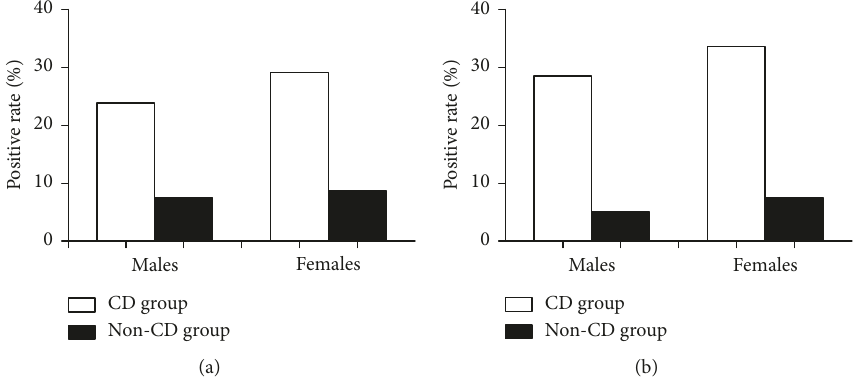
Figure 2: The positive rate of Demodex folliculorum (a) and Demodex brevis (b) in males and females in the CD and healthy